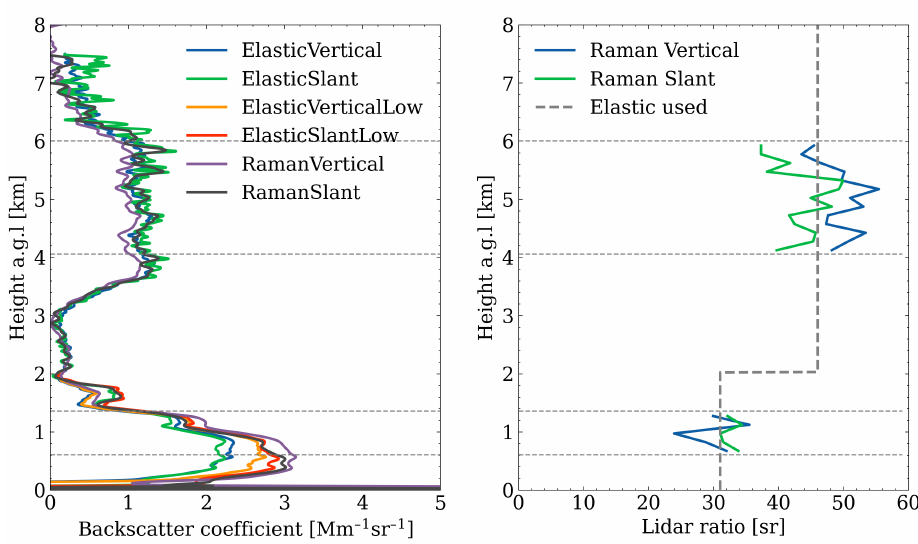
Figure 4. Backscatter coefficients from elastic and Raman methods for different optical paths ( left ) and LiDAR ratios retrieved ( right ) from 19:21 to 22:54 (UTC) on 8 April 2018. The retrieval for the elastic channel data uses two different LiDAR ratios at different altitudes. Elastic and Raman represent the channels of LiDAR data used in retrieval; vertical and slant represent the laser beam direction; low represents data retrieval for a low altitude (below 2 km), e.g., ElasticVerticalLow means the backscatter coefficient is retrieved from the elastic channel in the vertical direction for altitudes below 2